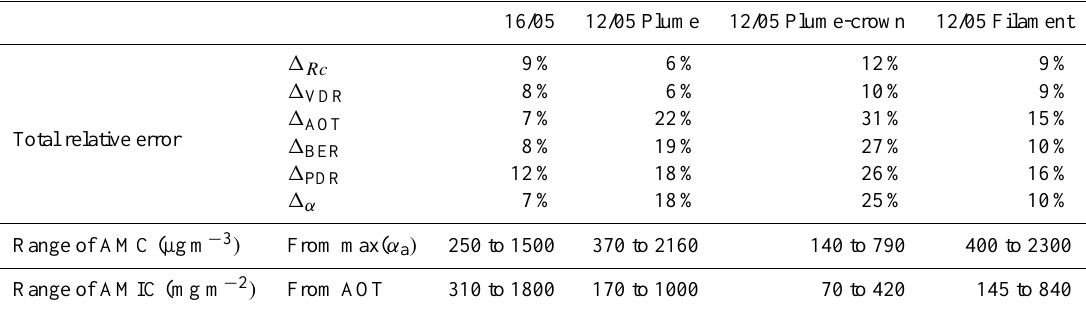
Table 4. Total relative error on the ash optical parameters. The uncertainties have been considered to be independent. The ranges of the ash mass concentration (AMC) and ash mass integrated concentration (AMIC) are also given accounting for the previous errors. The relative uncertainties on AMC and AMIC are the same as max( α a ) and AOT,